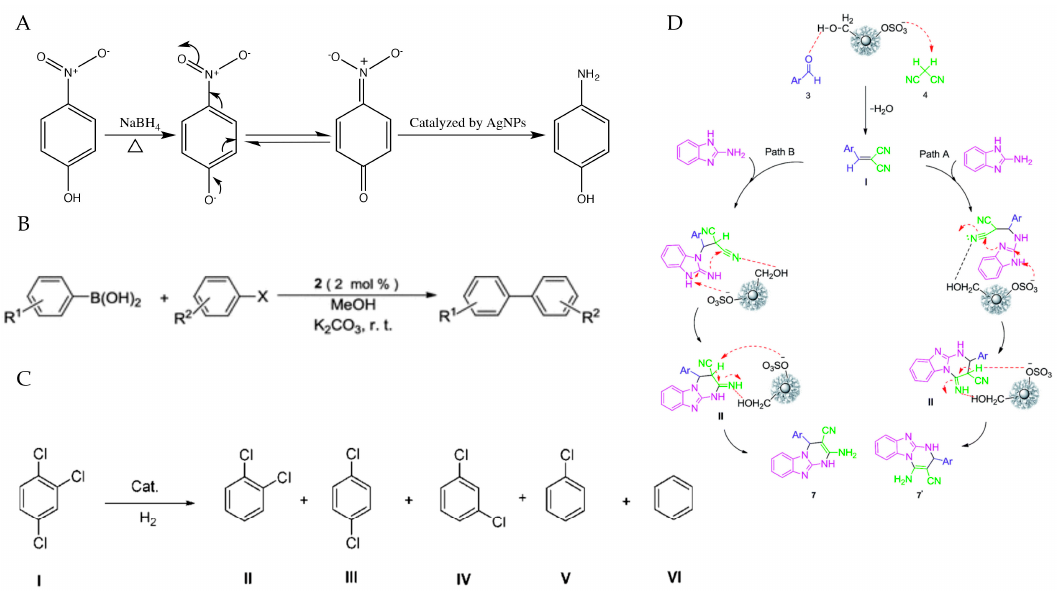
Figure 7. Overall scheme for the illustration of different catalytic reactions by PMNPs: ( A ) 4 -NP reduction catalyzed by arabinogalactan stabilized AgNPs; ( B ) Suzuki coupling reaction of aryl halide with arylboronic acid catalyzed by xylan-type hemicelluloses supported terpyridine-PdNPs; ( C ) hydrogenation of 1,2,4-trichlorobenzene catalyzed by Klebsiella oxytoca BAS-10 exopolysaccharides supported PdFeNPs; and ( D ) Synthesis of imidazopyrimidine derivatives catalyzed by Irish moss/Fe 3 O 4 nanoparticles. Reproduced with permission [97,185,199,201].